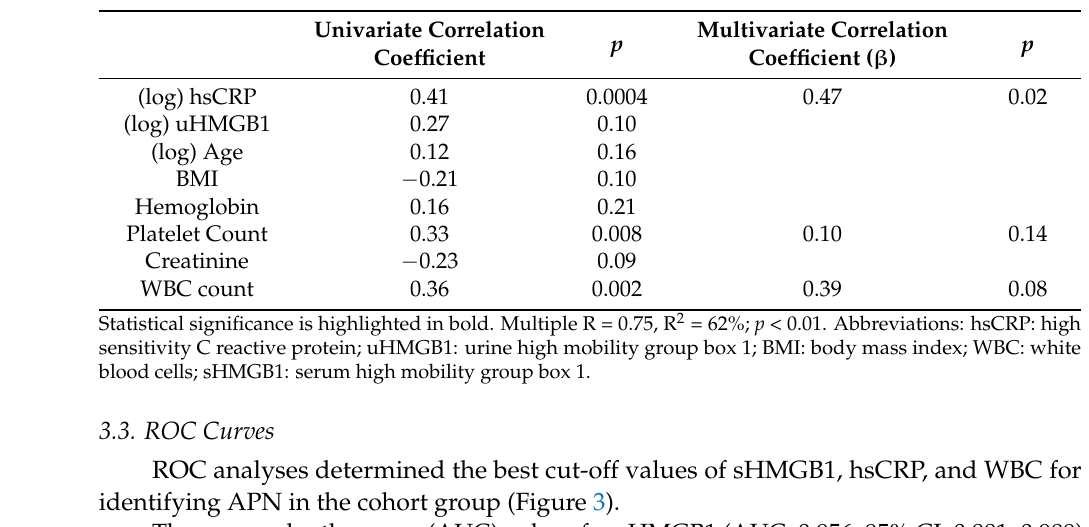
Figure 2. HMGB1 levels in the study population. Abbreviations: HMGB1: high mobility group box 1; LUTI: lower urinary tract infection; APN: acute pyelonephritis; HS: healthy subjects. Table 2. Univariate and multiple regression analysis of (log-transformed) sHMGB1